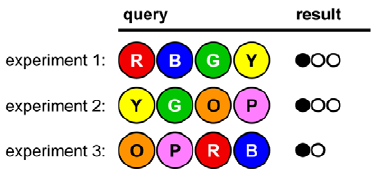
Figure 6. Opening strategy A, illustrat- ing Lesson 4.